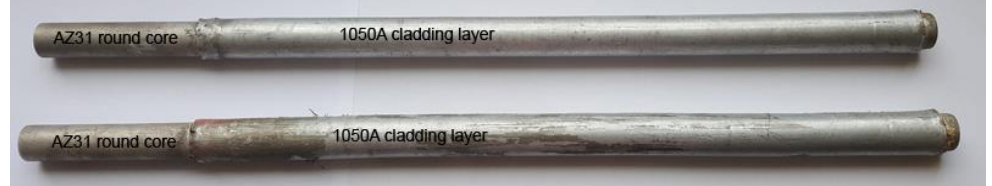
Figure 1. View of round Mg/Al bimetallic feedstocks after explosive welding.